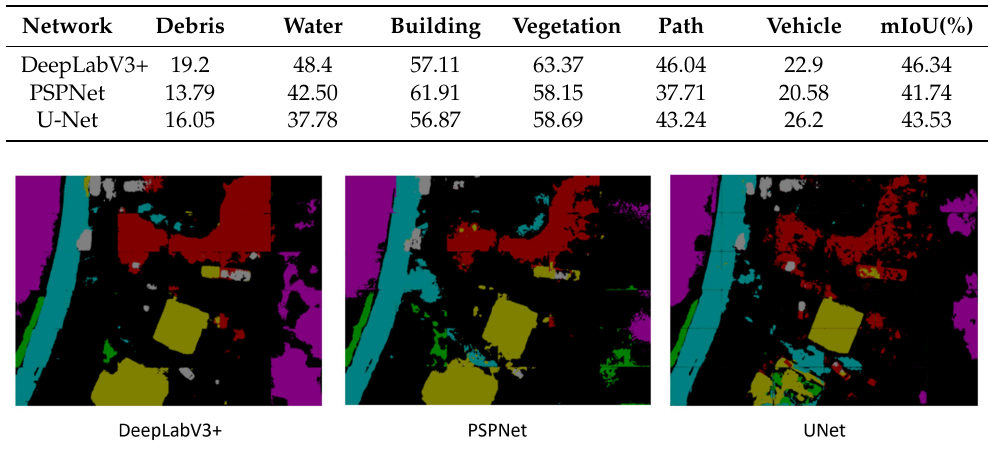
Figure 15. Semantic segmentation results comparison of DeepLabV3+, PSPNet and